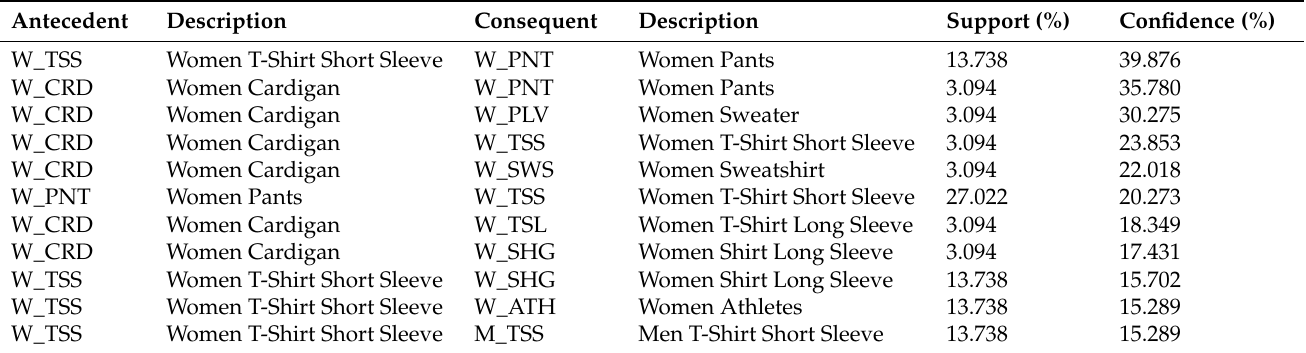
Table 5. Potential category pairs that can be recommended for the selected